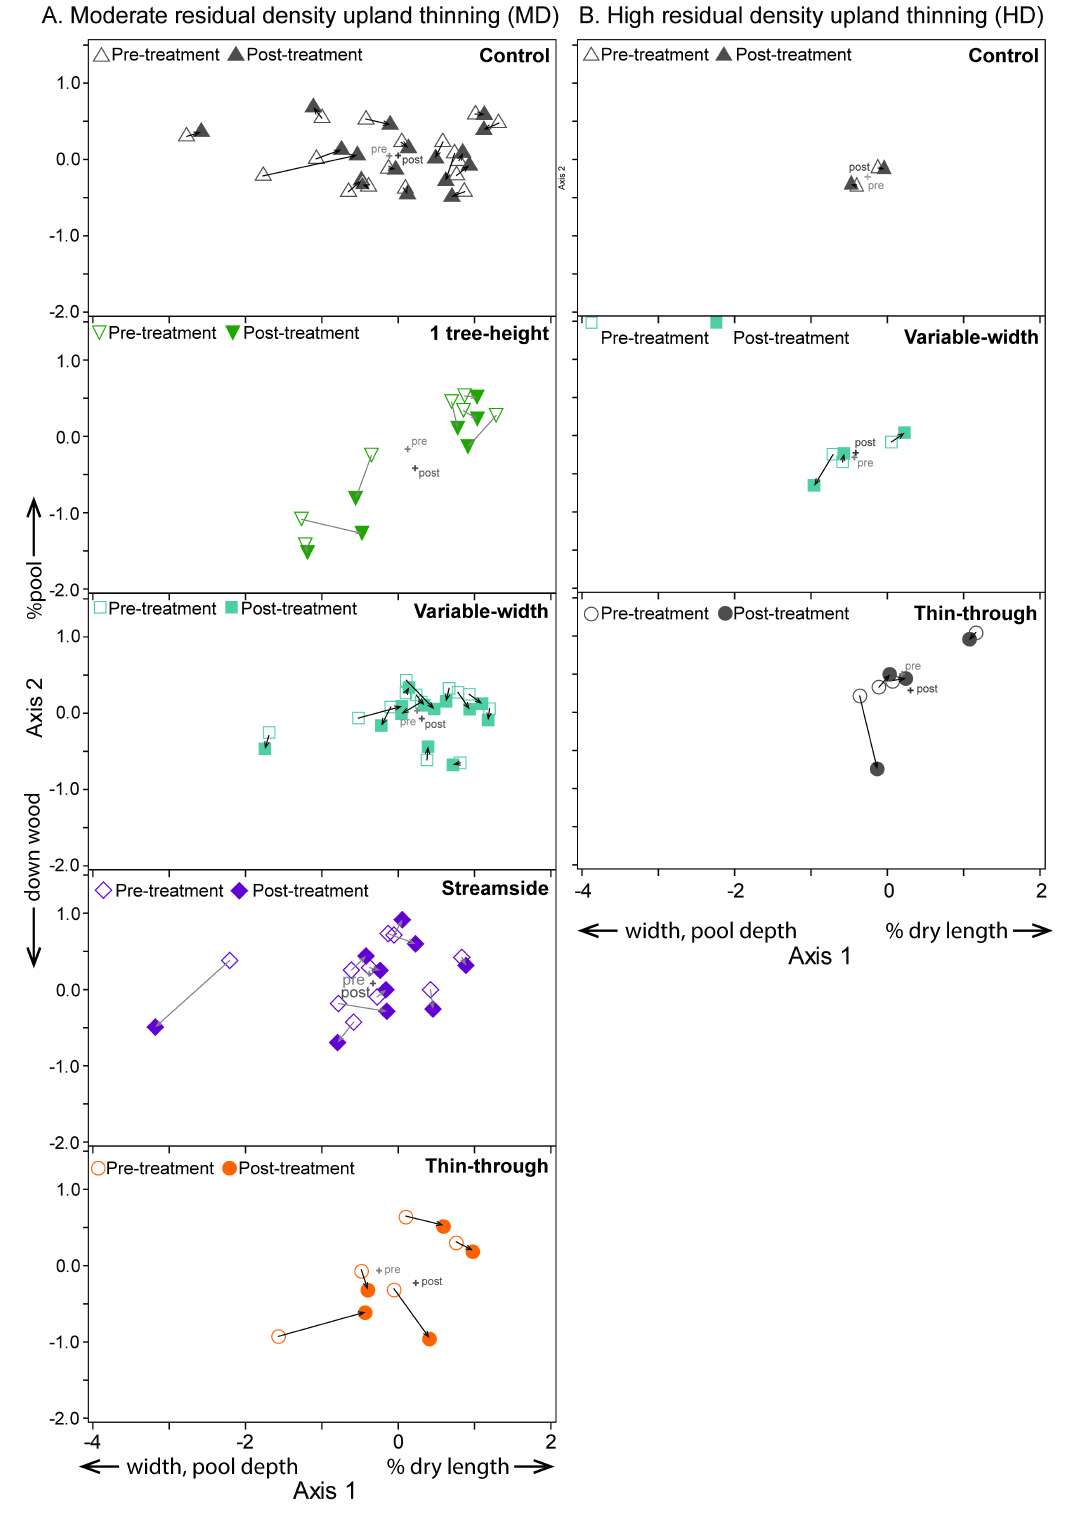
Figure 3. Changes in reach habitat structure by buffer treatment supported by non-metric multi-dimensional scaling ordination of 56 stream reaches described by 24 habitat characteristics; Open and solid symbols show reaches prior to and following second thinning treatments, respectively; centroids show mean locations; results for moderate-density thinning ( A ) are shown separately from high-density thinning ( B